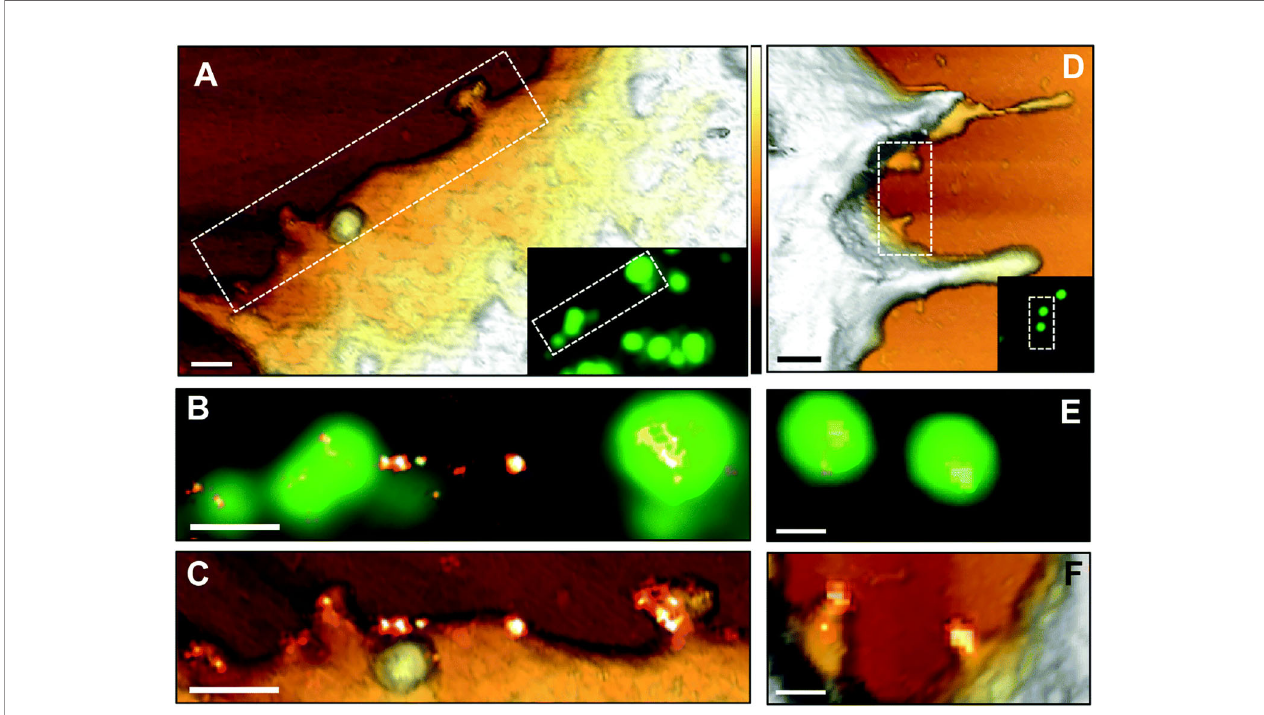
FIGURE 3 | AFM correlative-dSTORM super resolution microscopy demonstrates CD9 recruitment at HIV-1 budding sites. HIV-1 Gag-GFP expressing HeLa cells were labelled with anti-CD9-Alexa-647 and imaged by AFM (A, D) , conventional fl uorescence (B, E) and dSTORM (C, F) . Dotted rectangles on the AFM images (A, D) indicate areas examined at higher resolution by AFM (C, F) and by fl uorescence for the Gag-GFP signal (B, E) and the AFM images are overlaid with the reconstructed dSTORM image of tetraspanin CD9 (C, F) . Scale bars are 500 nm (A, D) or 200 nm (B, C, E, F) . The Z scale colorized in A and D is 300 nm, with the lightest regions representing the highest points. The fi gure has been reproduced from Dahmane et al. (2019) with permission from The Royal Society of Chemistry